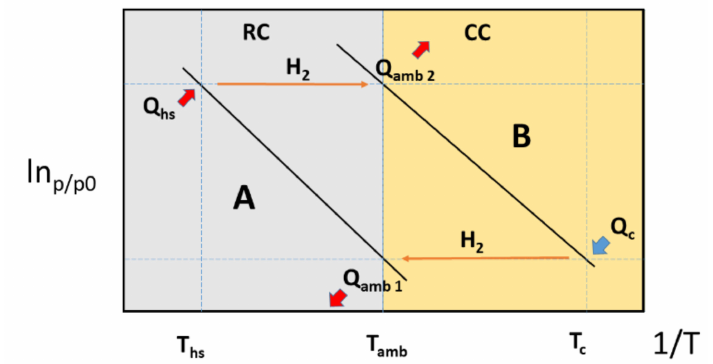
Figure 7. Schematic illustration of a MCHS operating principle using a van’t Hoff